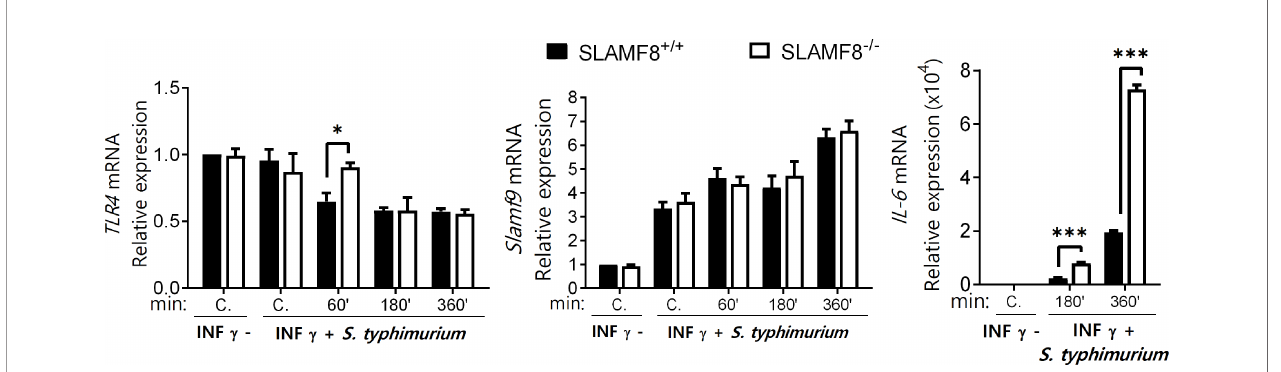
FIGURE 7 | SLAMF8 -/- pMø show differences in IL-6 expression, but not in SLAMF9 or TLRs expression. Expression levels of the indicated mRNAs as determined byquantitative RT-PCR in pMø treated with orwithout IFN g (100 U/ml) for 16 h,and then infectedwith wt S. typhimurium (MOI 10) at different chase times. Expression of gene expression was normalizedto basal expression levelsofuntreated cells (0/0).Datawere analyzed bythe 2 − DD Ct method and HPRT1 was used as the reference gene. Results of two independent experiments are shown . *p < 0.05; ***p < 0.001. C, Control.